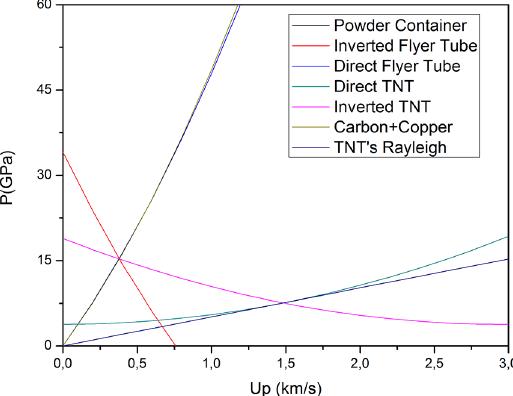
Figure 3. Hugoniot curves obtained by the detonation of TNT explosive.